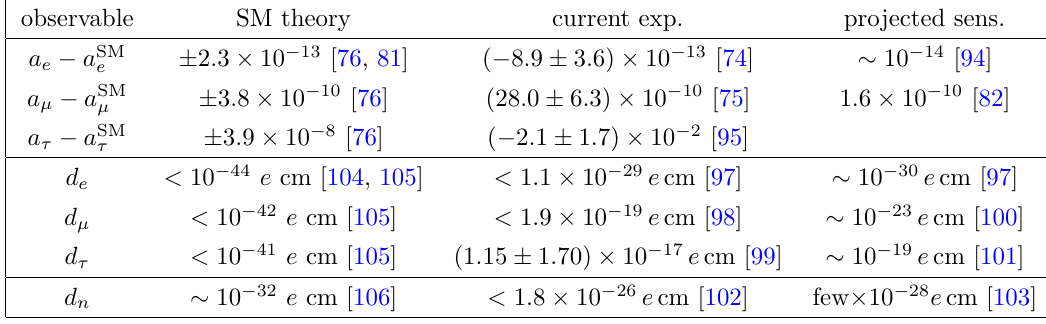
Table 1 . Summary of Standard Model theory errors/bounds ((cid:12)rst column), current experimental measurements/limits (second column) and projected precision of next-generation experiments (third column) of magnetic moment anomalies and electric dipole moments of the charged leptons and the neutron. For clarity, for the anomalous magnetic moments, the Standard Model central values have been subtracted. We are not aware of any experimental analysis for the projected sensitivity of the tau magnetic